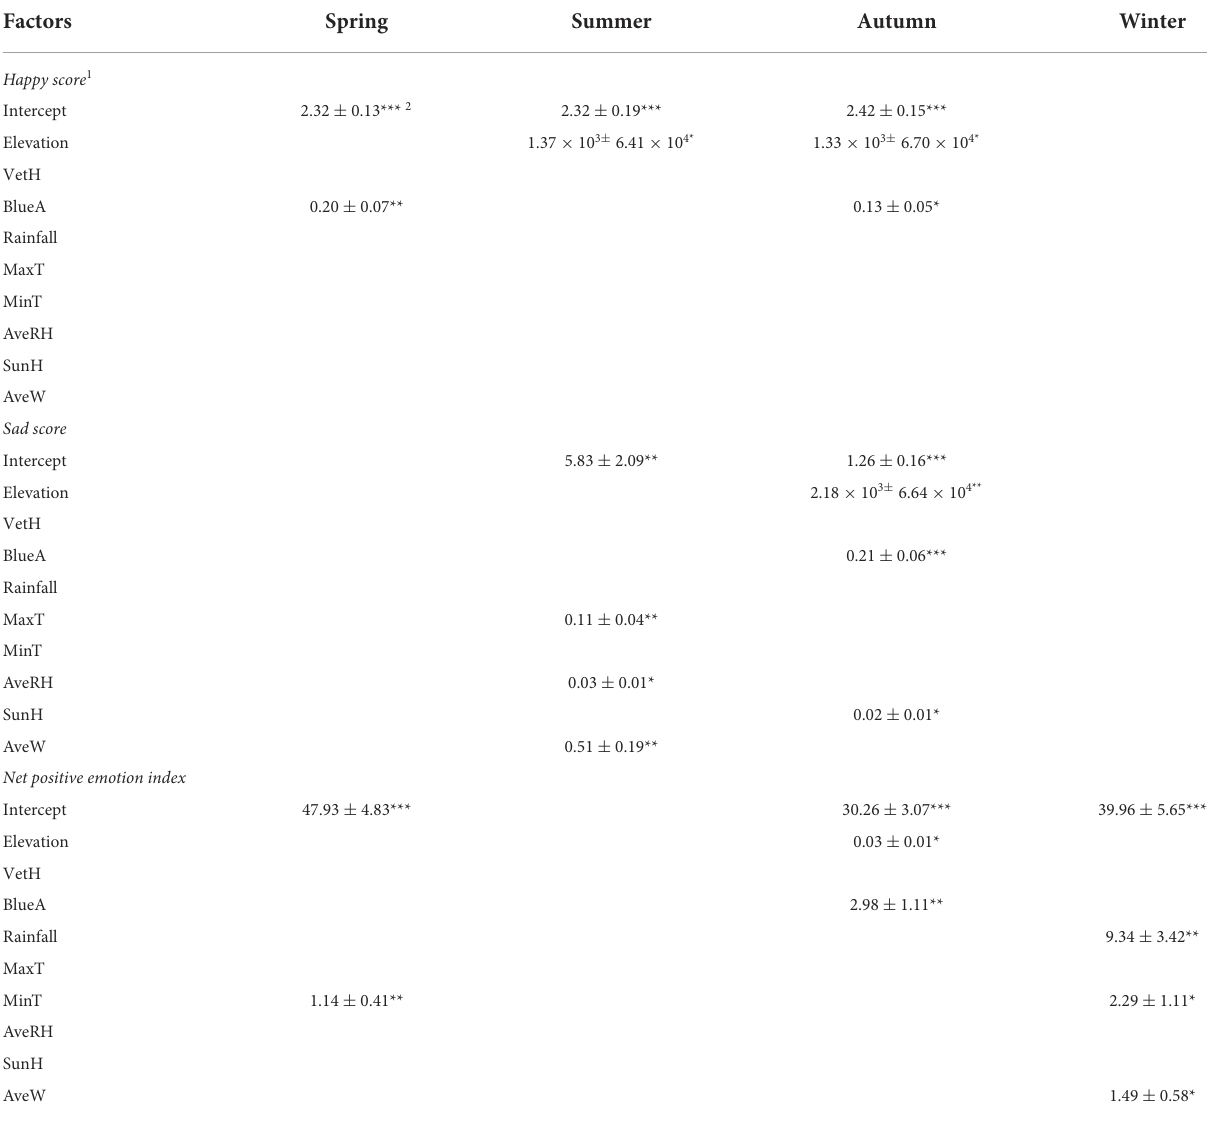
TABLE 4 Parameter estimates from multivariable linear regressions of factors of landscape metrics and microclimates on facial expression scores of people experiencing urban wetland parks across four seasons. Factors Spring Summer Autumn